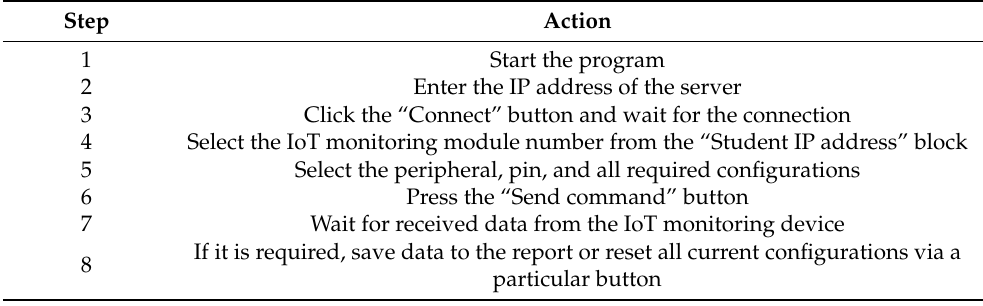
Table 1. Procedure for using the control application—teacher’s